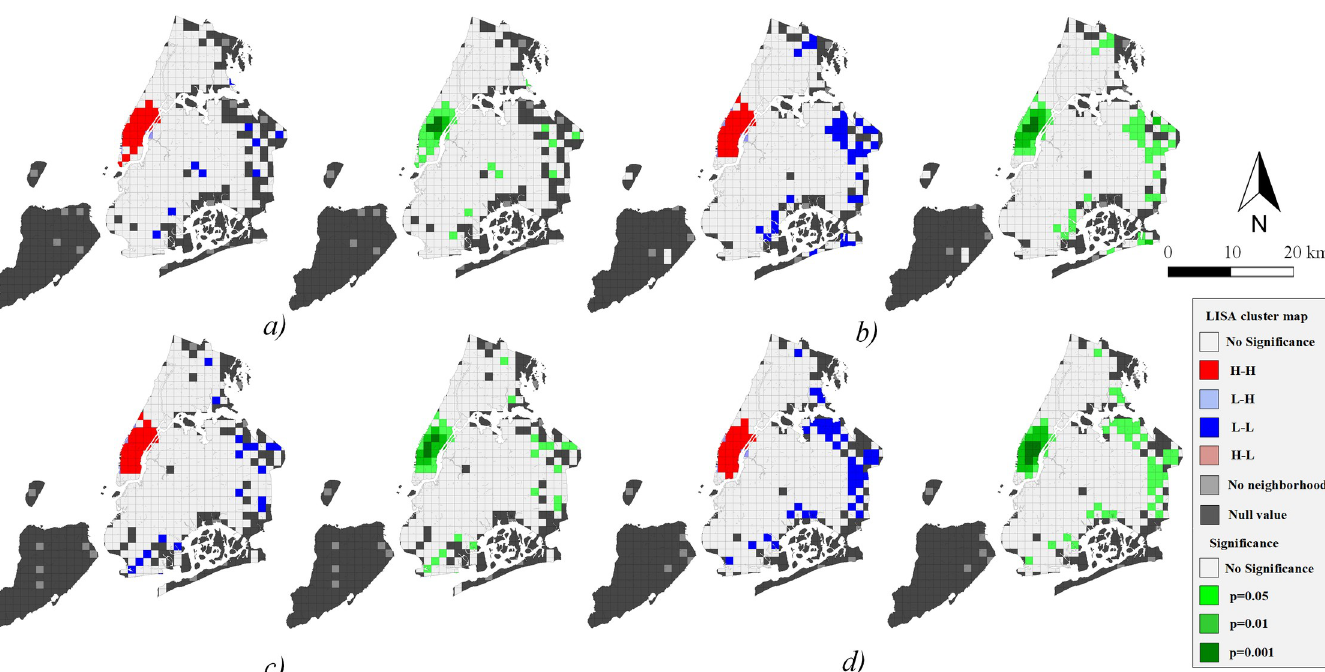
Fig 9. Spatial autocorrelation of destination demand. a) peak1 ; b) peak2 ; c) peak3 ; d) peak4 .